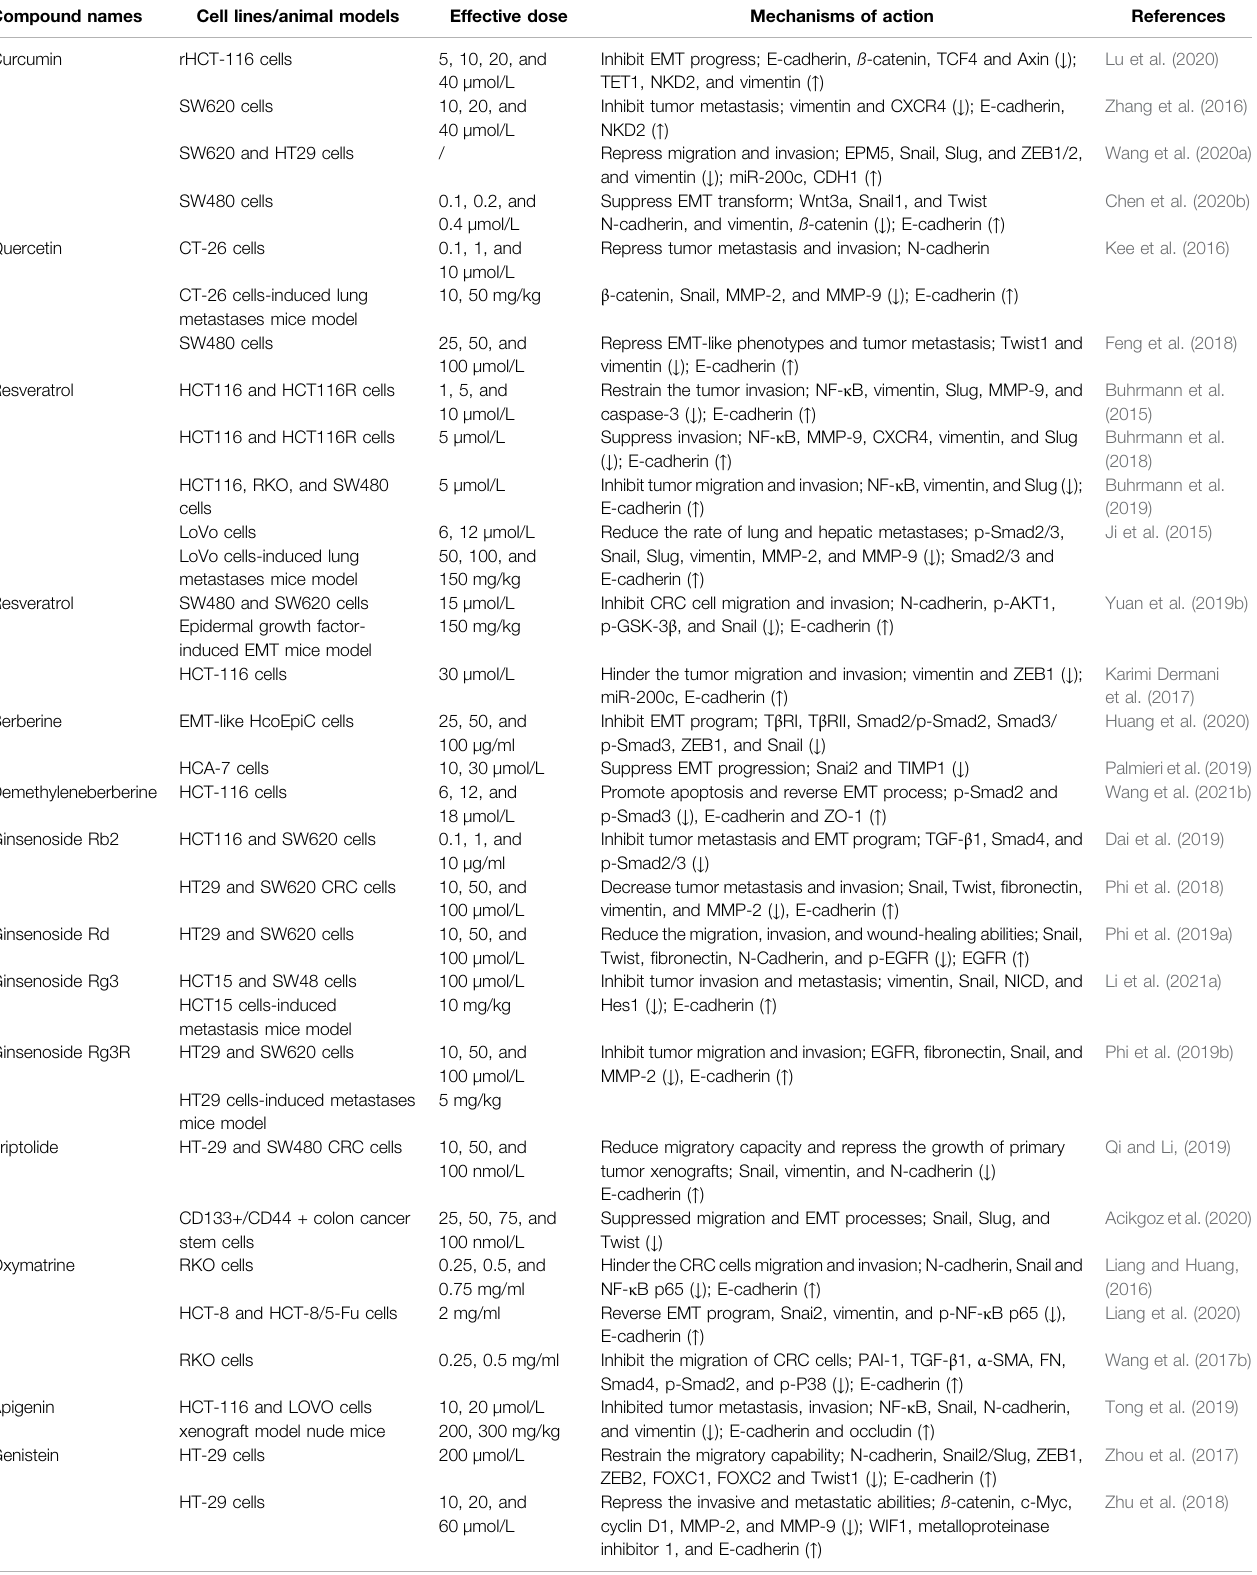
TABLE 1 | Targeting of EMT-related signaling pathways involved in metastatic CRC by natural bioactive compounds in vitro and in vivo . Compound